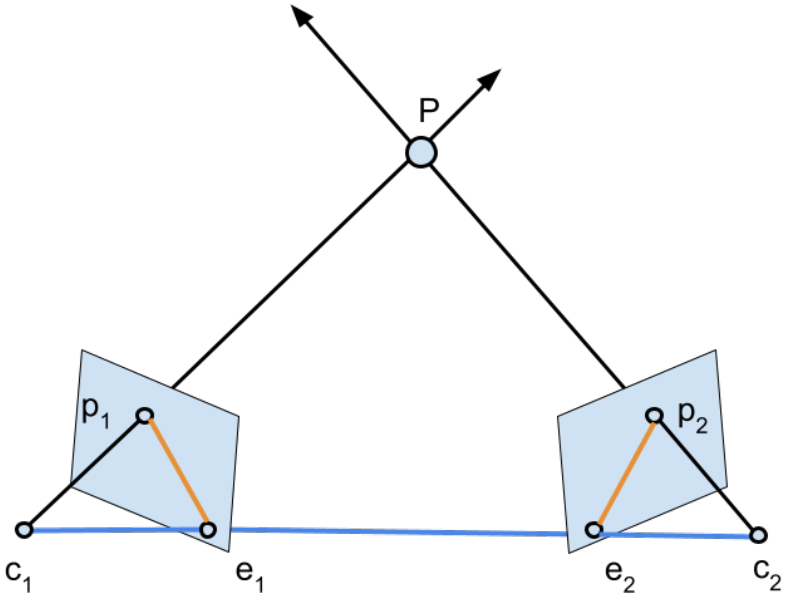
Figure 1. The general setup of epipolar geometry. The planar region defined by the points P , c 1 , and c 2 is the epipolar plane. The blue line is the baseline, while the two orange lines are the epipolar